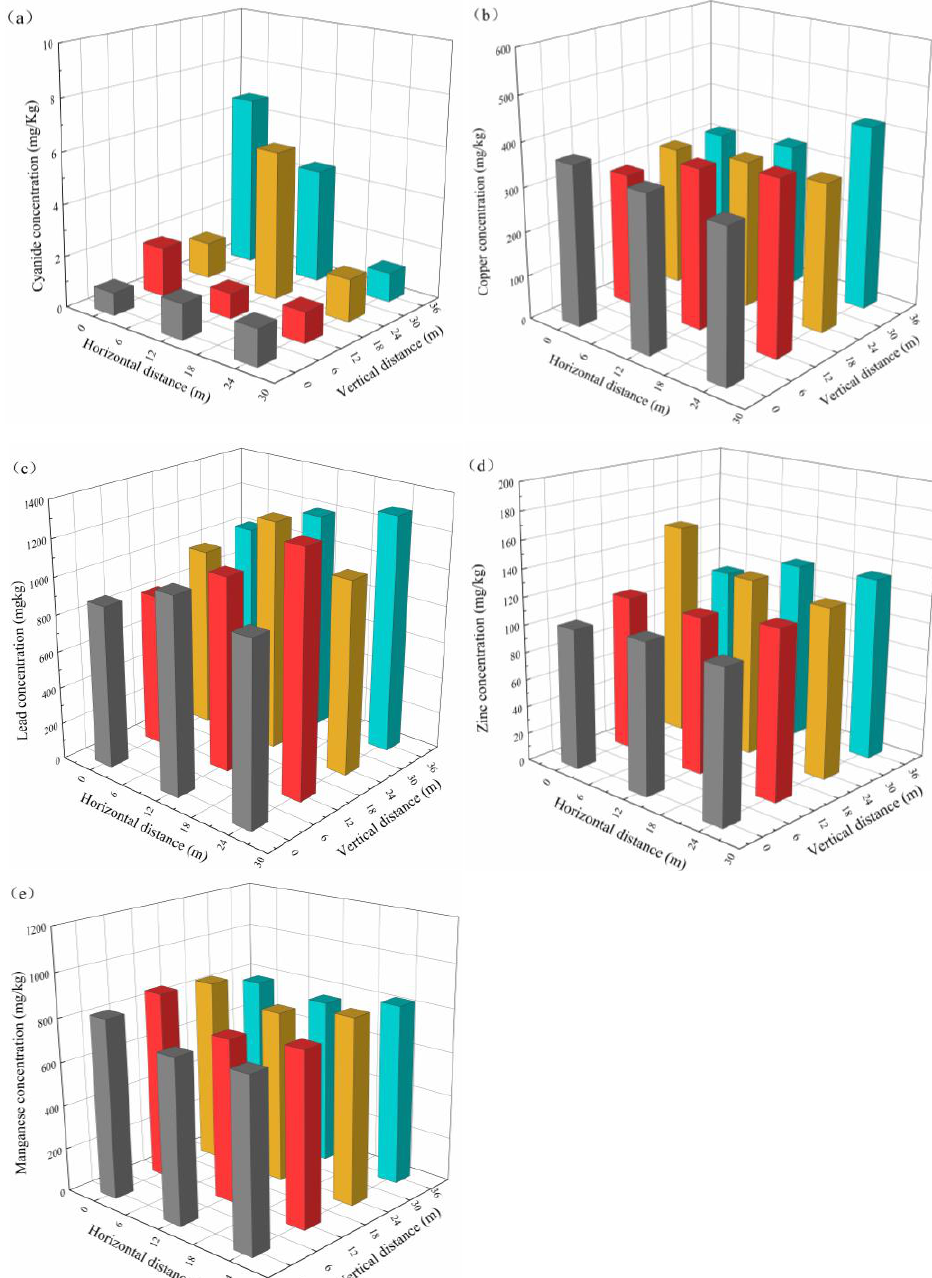
Figure 7. Distribution diagram of cyanide and heavy metal concentration in horizontal direction in tailings pond ( a ) cyanide, ( b ) Cu, ( c ) Pb, ( d ) Zn, ( e ) Mn.